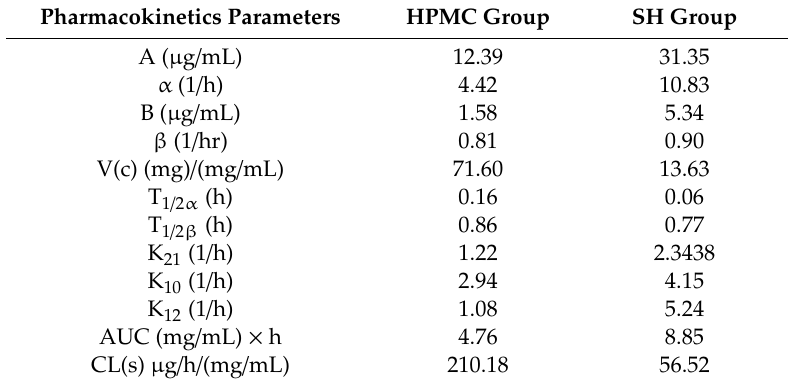
Table 2. Pharmacokinetics parameters of AZI in tear fluid after topical administration in the conscious rabbits ( n = 5).